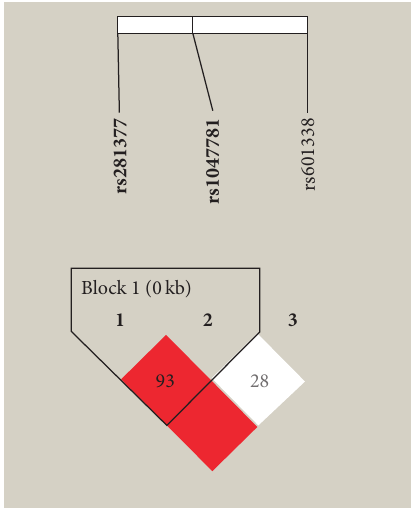
Figure 1: The linkage disequilibrium patterns of FUT2 gene in Han population from Southeast China. The number in a square represents D 󸀠